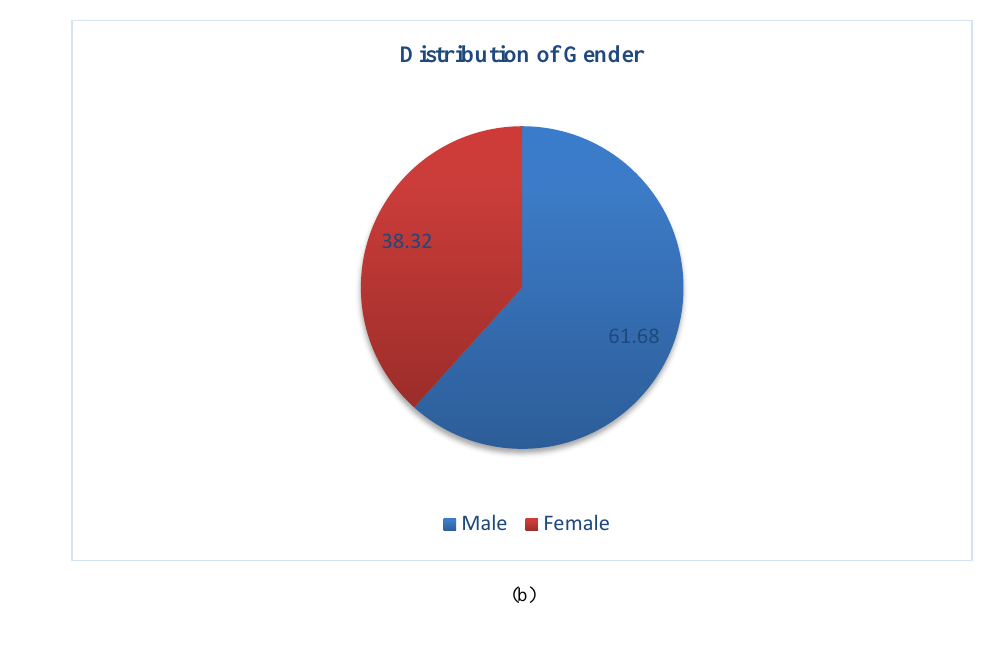
Fig. 1. Distribution of study participants in (a) Age group with sex, (b) Gender wise.